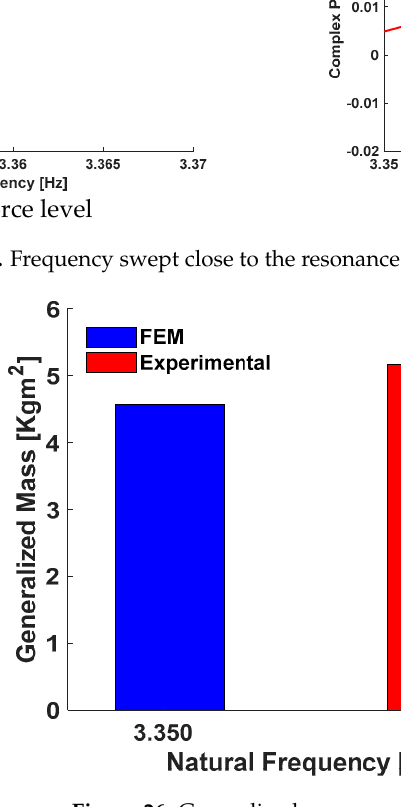
Figure 26. Generalized mass comparison.